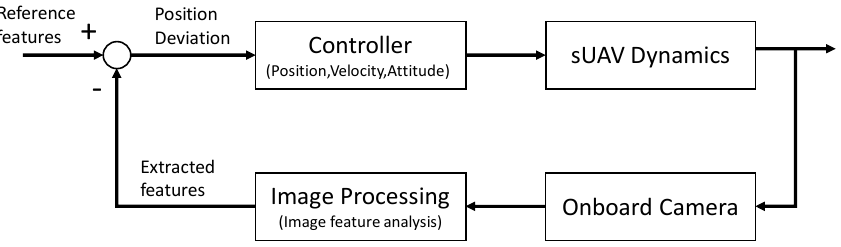
CameraImage Processing CameraImage Processing Onboard Onboard (Image feature analysis) (Image feature analysis) Figure 13. Concept of vision system as a feedback sensor for controlling the sUAV. Figure 13. Concept of vision system as a feedback sensor for controlling the sUAV. Figure 13. Concept of vision system as a feedback sensor for controlling the